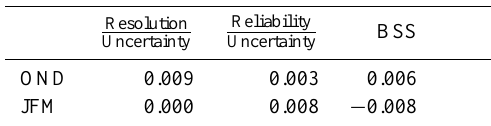
Table 2. For the early and late season, BSS, and its decomposition terms for in-situ observations in